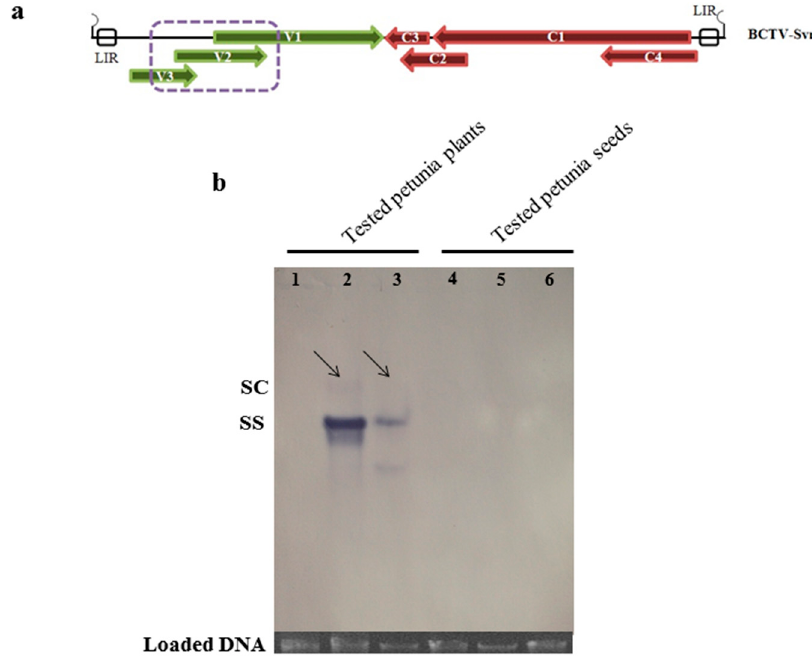
Figure 5. ( a ) Linearized diagram of BCTV-Svr genome. Arrows indicate coding sequences and purple dotted box indicates the region used for preparing probe for PCR ELISA (DIG labeling) and BCTV-Svr358 V /877 C primer pair; ( b ) Southern blot hybridization of total DNA extracted from: a healthy PCSP plant as negative control (lane 1), an agroinoculated PCSP plant as positive control (lane 2), an infected plant developed from seed of local cultivar (lane 3), seeds of healthy PCSP used as negative control (lane 4), seeds of agroinoculated PCSP cultivar (lane 5) and seeds of naturally infected local petunia cultivar (lane 6). Loaded DNA of each sample stained with ethidium bromide is shown at the bottom of the blot panel. sc (BCTV-Svr supercoil double-strand DNA, which is shown by the arrows); ss (BCTV-Svr single-strand DNA).